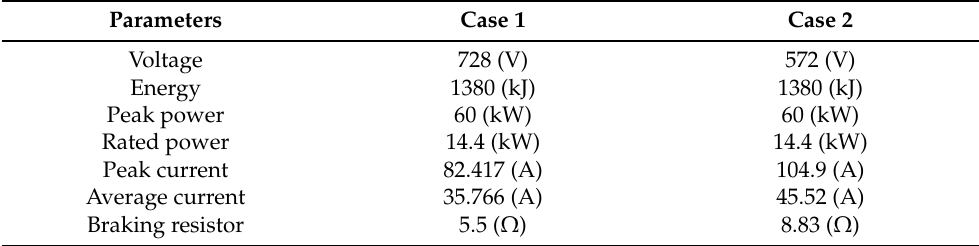
Table 5. Calculation of braking resistance for the two cases.